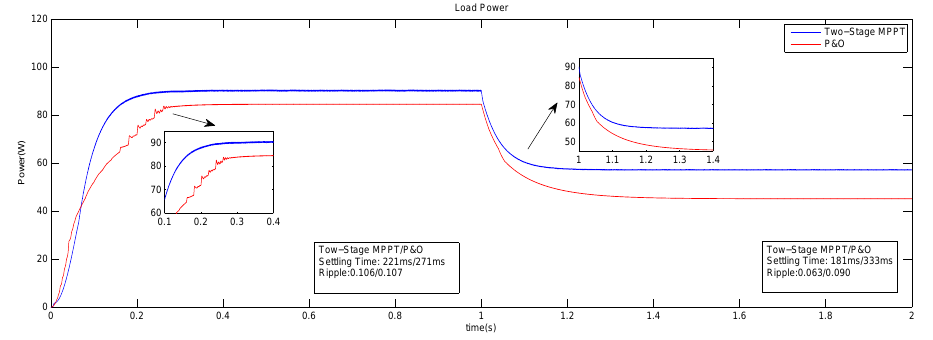
Figure 8. Load power under irradiance changes.